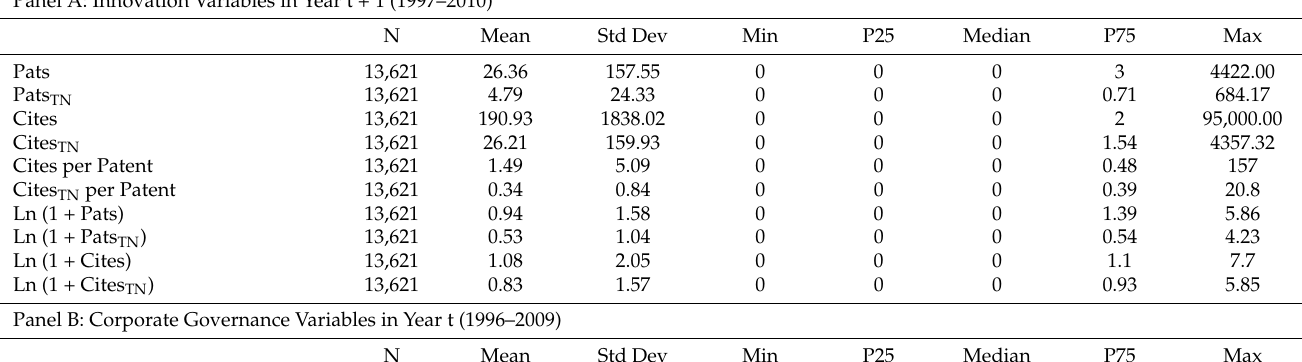
Table 2 looks more specifically at these innovation variables, by year and by industry.